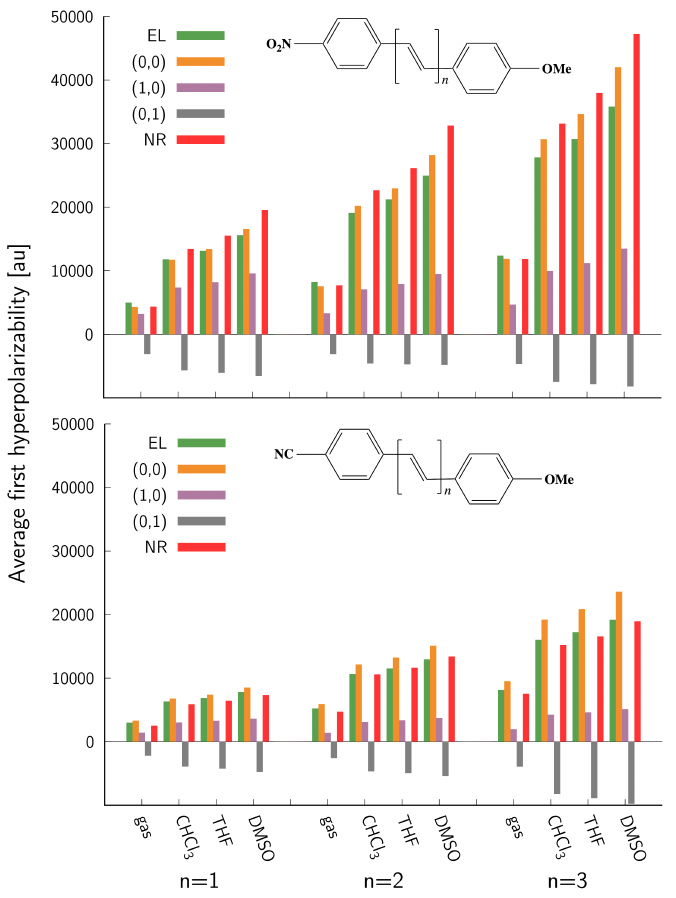
Figure 2. Boltzmann-weighted electronic and vibrational contributions to β (cid:107) , D = OMe, A = NO 2 (series 1 , top ) and D = OMe, A = CN (series 2 , bottom